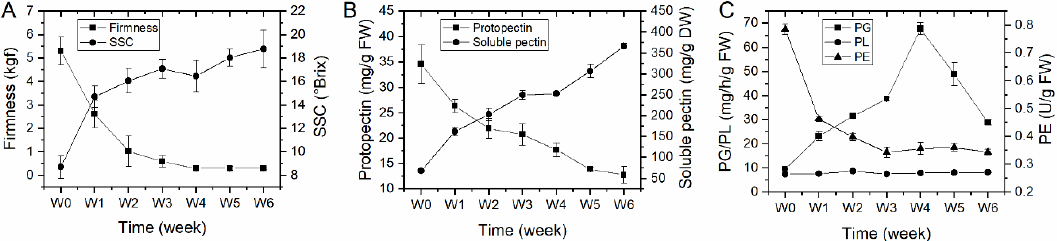
Figure 4. Fruit components, pectin content and activities of pectin degrading enzymes during kiwifruit ‘Donghong’ softening. ( A ) Fruit firmness and soluble solids concentration (SSC) measurement. ( B ) Protopectin (water insoluble pectin) and water soluble pectin content measurement. ( C ) Pectin degrading enzymes including PG (polygalacturonase), PL (pectate and pectin lyases) and PE (pectinesterase) activity measurement. Three biological samples were used for each analysis. Data are the means ± standard deviation (SD) bar.